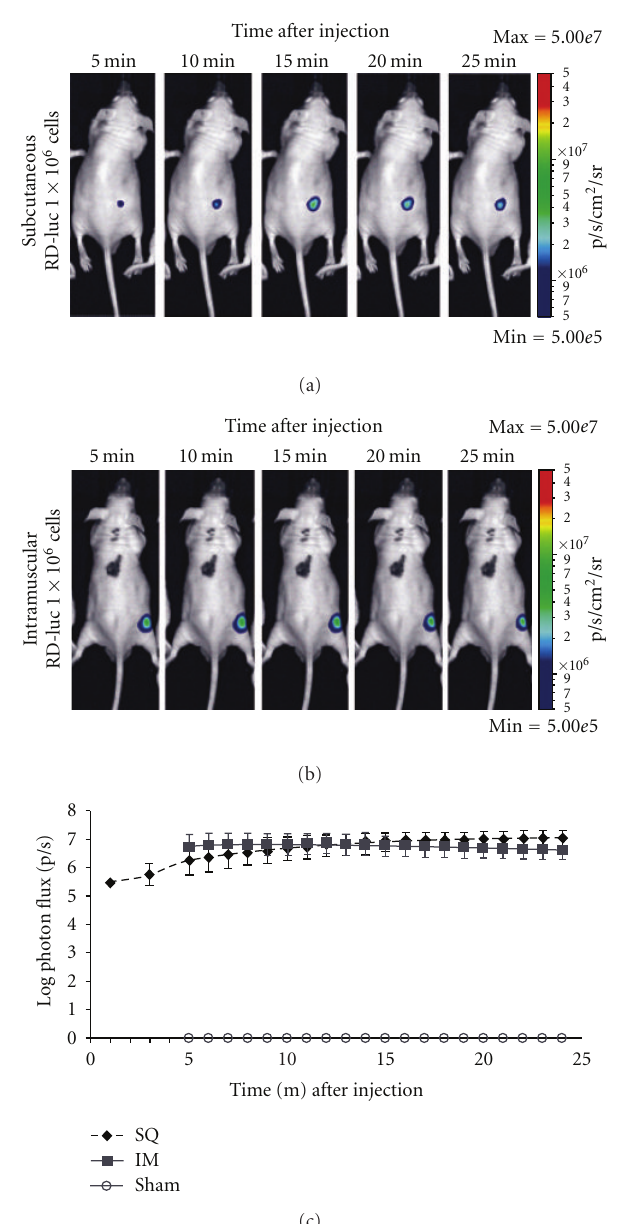
Figure 1: Luciferin uptake and signal stabilization. Biolumines- cence imaging was used to verify tumor placement three hours after (a) subcutaneous or (b) intramuscular inoculation of RD-luc cells. Imaging was initiated one-minute following a single, 150mg/kg I.P. bolus of d-luciferin mice, and photon flux data was collected in successive one minute intervals. (c) Average log-photon flux ± 1SD of n = 4 mice demonstrating a detectable signal within 1 minute following luciferin injection and was stable for a period ranging from 10 to 24 minutes after-injection. No signal was detected in animals injected with cell-free